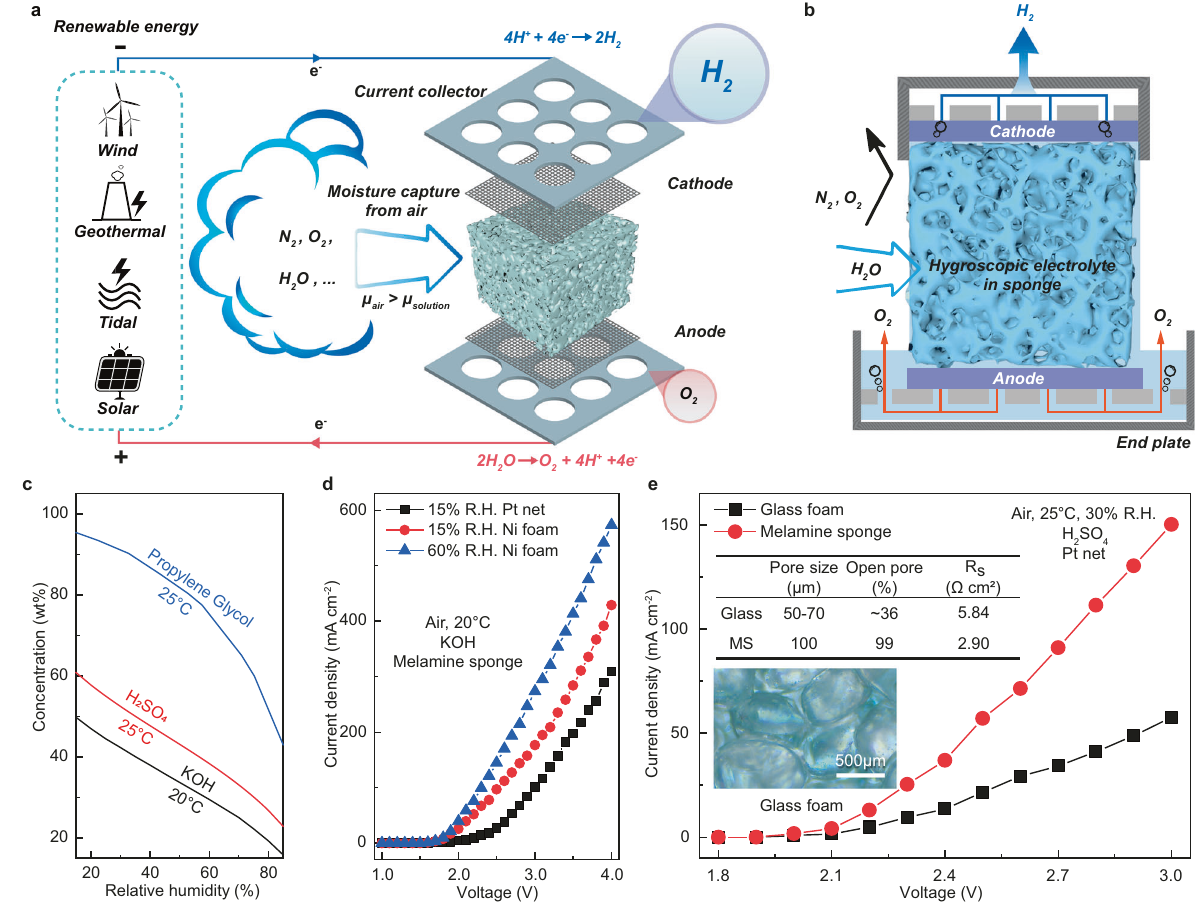
Fig.2|Theconceptofdirectairelectrolysis(DAE)forhydrogenproduction.a A schematicdiagramoftheDAEmodulewithawaterharvestingunitmadeofporous medium soaked withthe hygroscopic ionic solution. b A schematicdiagram of the cross-section of the DAE module, showing the electrodes are isolated from the air feed, and the absorbed water are transported to the electrode by capillaries of the sponge. c Equilibrium water uptakes of hygroscopic solutions at different air